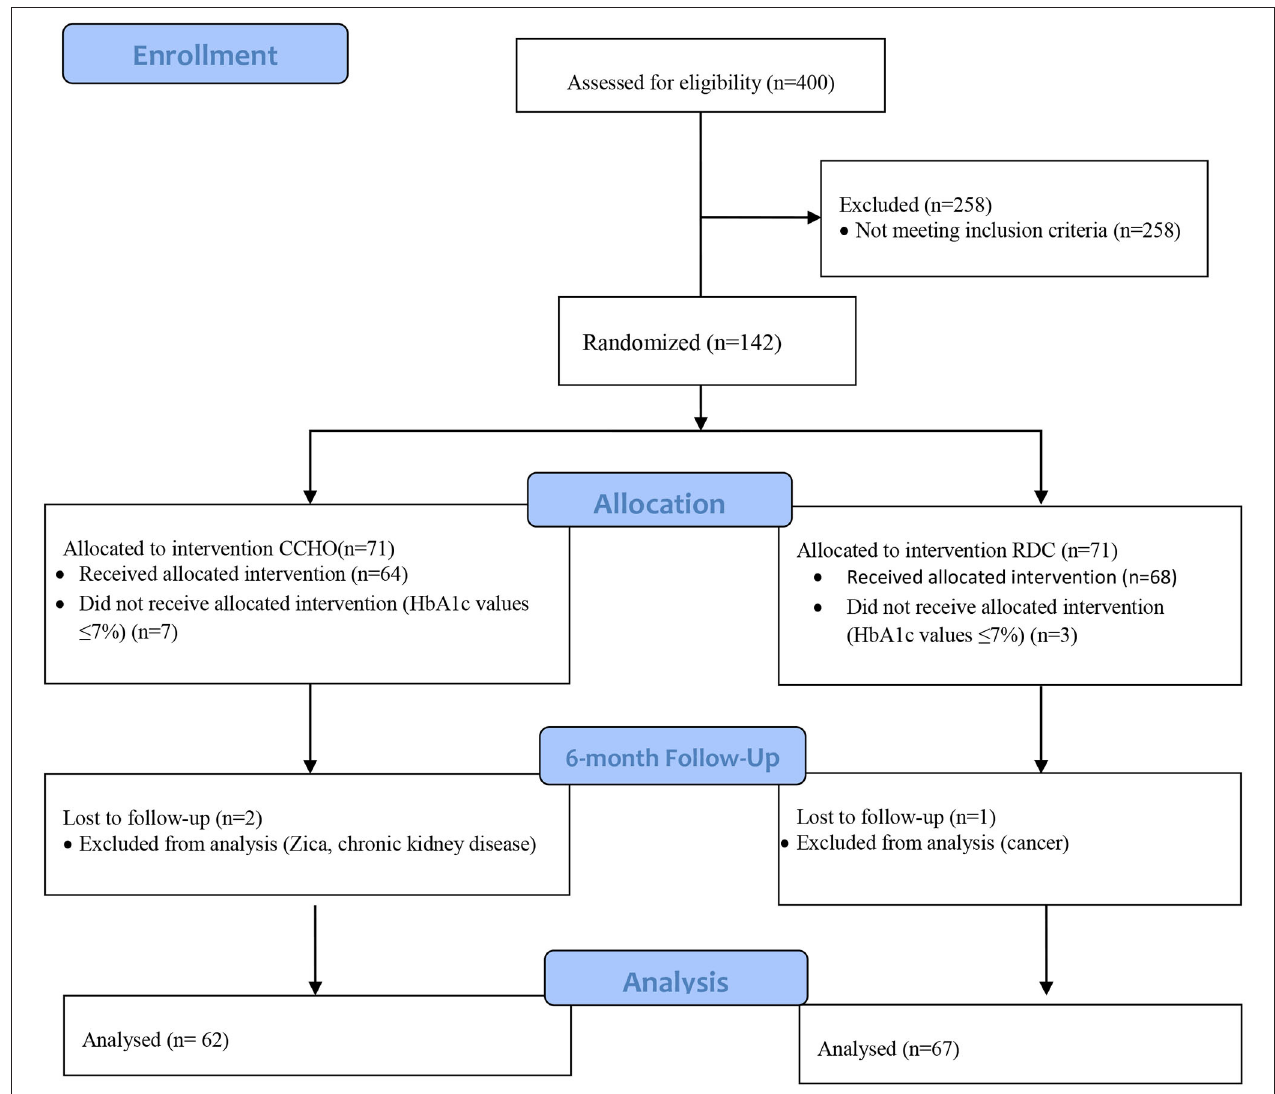
FIGURE 1 | Flow chart of the selection